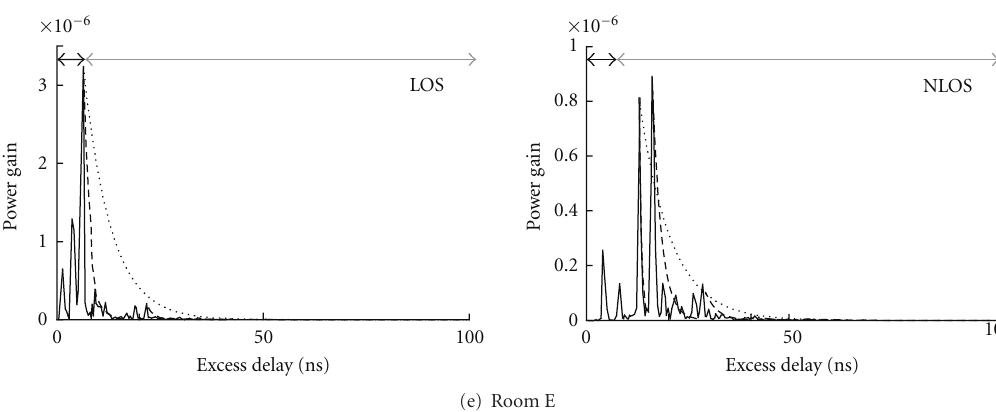
Figure 6: Examples of the delay profiles measured in Rooms A to E. Profiles for LOS were measured at the center of the back and those for NLOS at the center of the chest. The dashed lines represent exponential power decay of the rays and the clusters. The black and grey arrows indicate the first and the second domains.